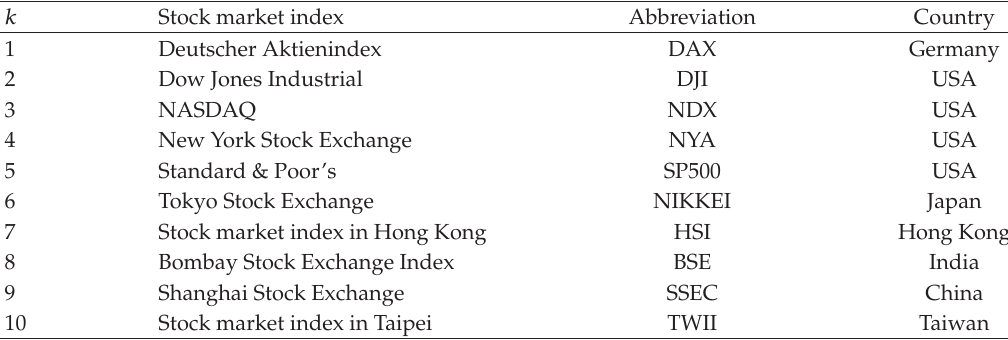
Table 2: The ten stock markets adopted in the